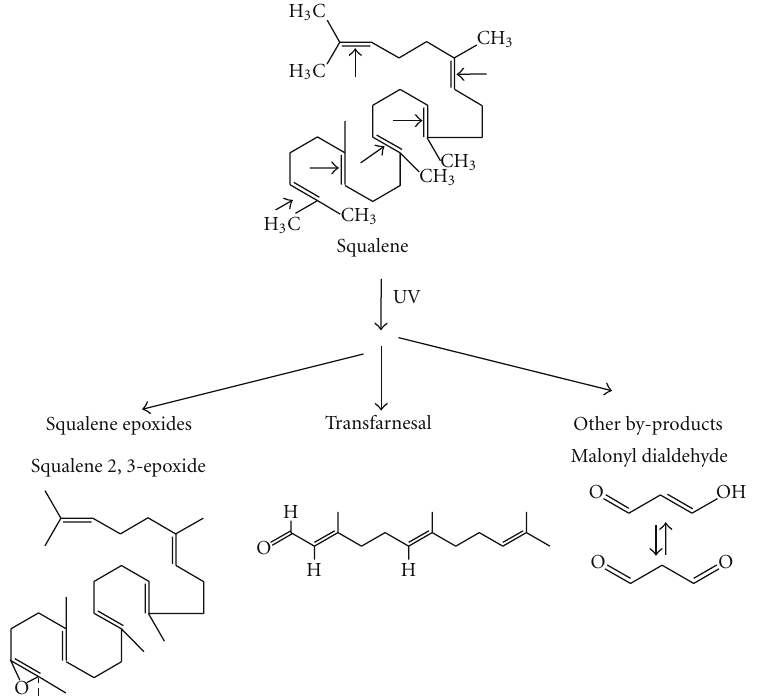
Figure 1: Chemical structures of squalene and of its main photo-oxidation labile or stable by-products, generated in vitro under UV